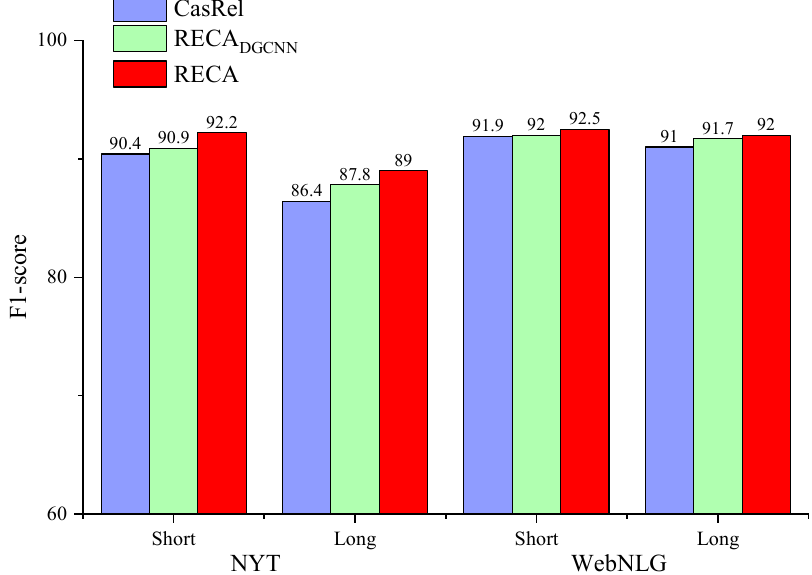
Figure 5. Result for long-sentence experiments with the NYT and WebNLG datasets. Table 4. F1-scores for the extraction of relational triplets from sentences with different numbers of triplets. The best scores are in bold font.